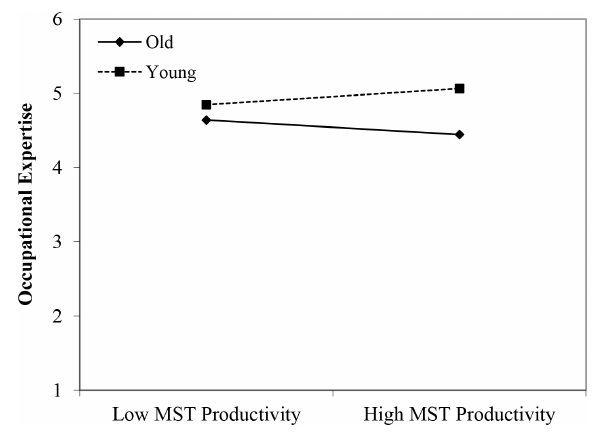
FIGURE 2 | Interaction between the age-based (meta-)stereotyping of productivity and age groups: Predicting occupational expertise. Low = –1 SD , High = + 1 SD , MST = age-based (meta-)stereotyping, old = older workers, young = younger